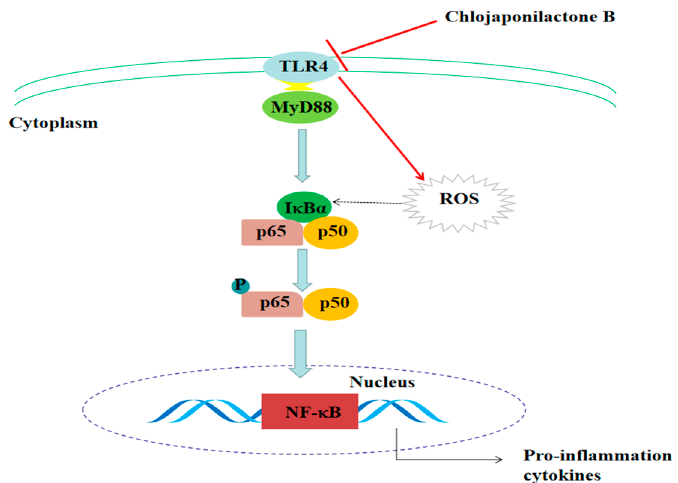
Figure 7. Scheme summarizing that 1 attenuated LPS-induced inflammatory responses by suppressing TLR4-mediated ROS generation and NF- κ B signaling pathway. Supplementary Materials: NMR ( 1 H, 13 C) spectra of compound 1 , and the method and results of cytotoxicity test on compound 1 and